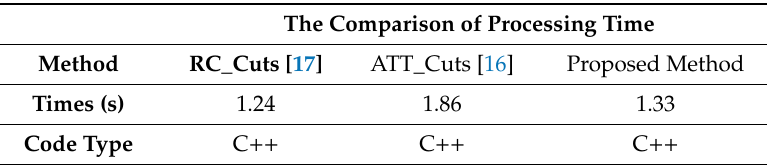
Table 3. The comparison of processing time obtained by each